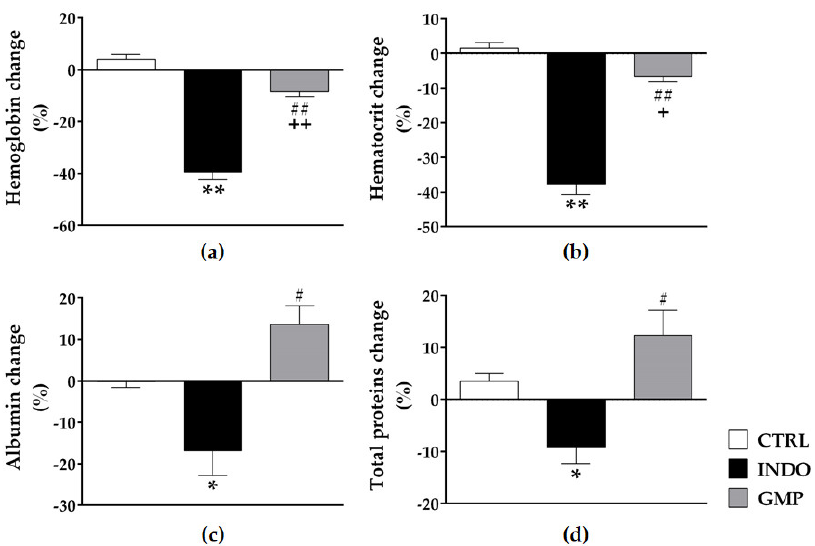
Figure 3. Effect of treatment with glycomacropeptide (GMP) on hematological and biochemical parameters in indomethacin-induced enteropathy. Hemoglobin ( a ) and hematocrit ( b ), as hematological variables, were measured in blood and represented as percentage (%) change at day 15 with respect to day 7. The quantity of albumin ( c ) and total proteins ( d ), as biochemical markers, was measured in serum and represented as percentage (%) change at day 15 with respect to day 7. Data are presented as mean ± SEM. CTRL and GMP, n = 14; INDO, n = 11. * p < 0.05 and ** p < 0.0001 INDO vs. CTRL; # p < 0.001 and ## p < 0.0001 GMP vs. INDO; + p < 0.01 and ++ p < 0.0001 GMP vs. CTRL.